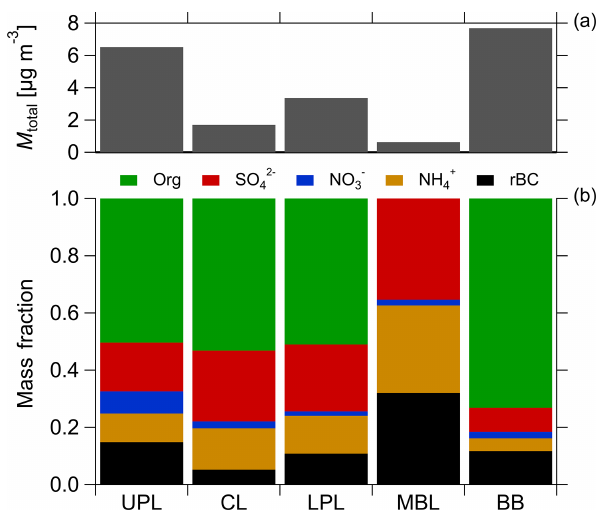
Figure 6. Cumulative mass concentrations of non-refractory submi- crometer species (i.e., organic (Org), sulfate (SO 2 − ammonium (NH + )) and rBC (a) ; and mass fractions of the respec- 4 tive species to the total mass ( M total = M Org + M SO + M M NH rBC ) in the UPL, CL, LPL, and MBL, as defined in Fig. 3, 4 and the fresh BB plumes probed during AC19 (see Fig. 1) (b) . Note that no C-ToF-AMS data were available from 17:27 to 19:05UTC during the offshore section of flight AC19 and, therefore, a reduced number of measurements points are included in the averages. The concentration of organics was below the detection limit in the